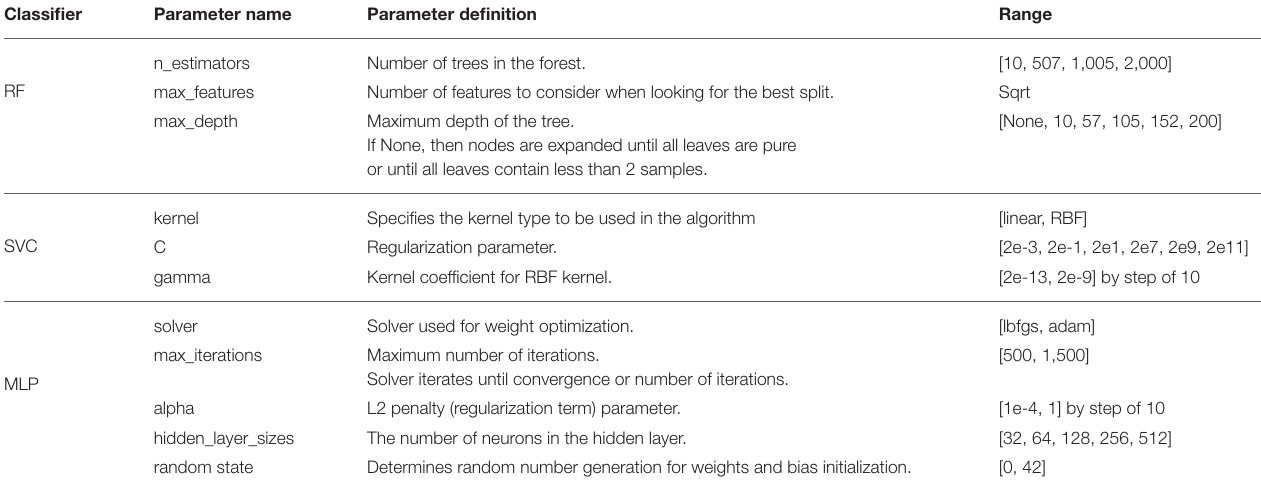
TABLE 3 | Tweaked hyperparameters during the first iteration of the grid search procedure (GridSearch 1 ), with chosen ranges and step values for each